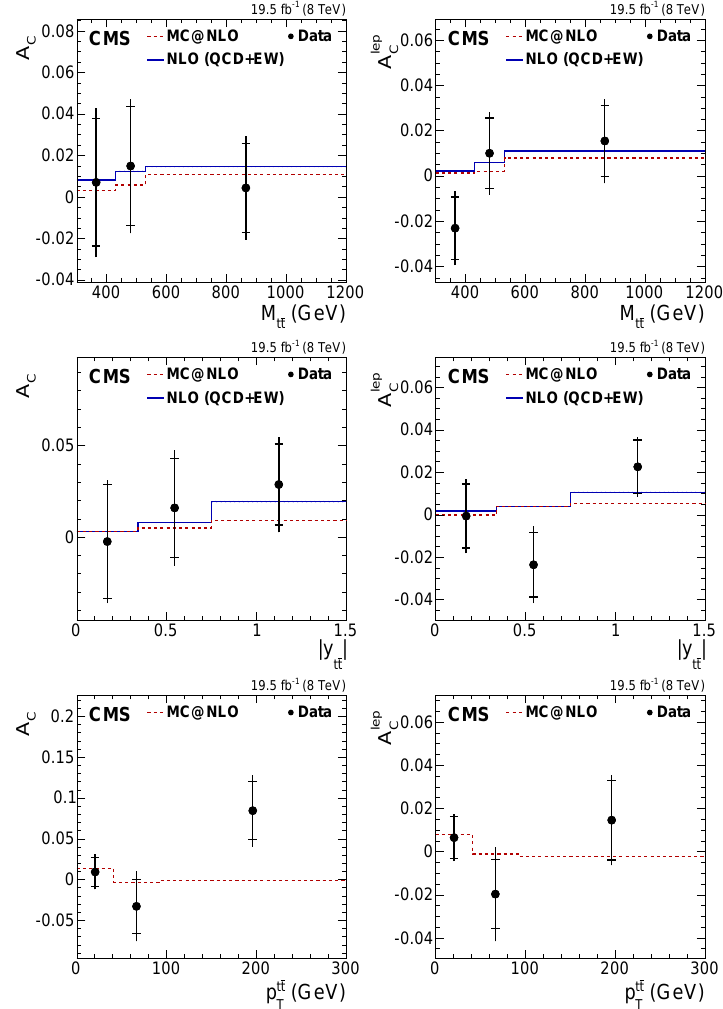
| , and p t ¯ t [44] compared to the t ¯ t T